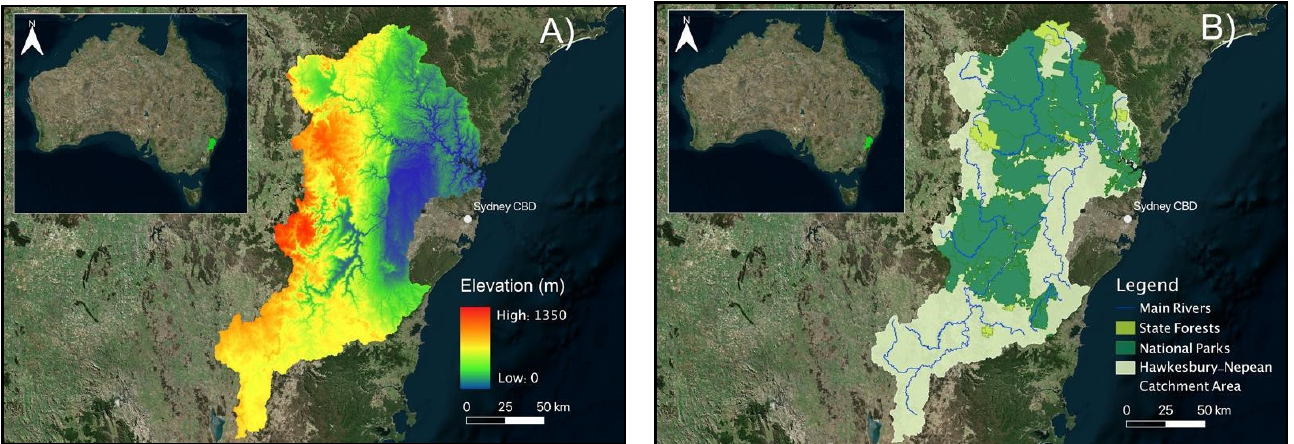
Figure 2. Topographical and river outline maps of the Hawkesbury-Nepean Catchment region. ( A ) illustrates the topography, and ( B ) depicts the conservation areas and river system. Made using ArcMap 10.7 software.